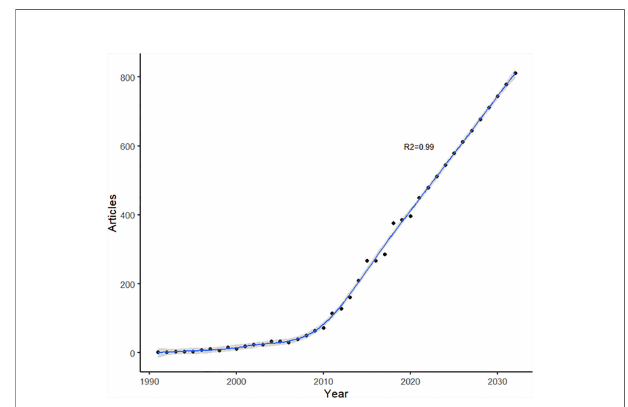
FIGURE 1 | Number of annual articles on schizophrenia and in fl ammation by years.